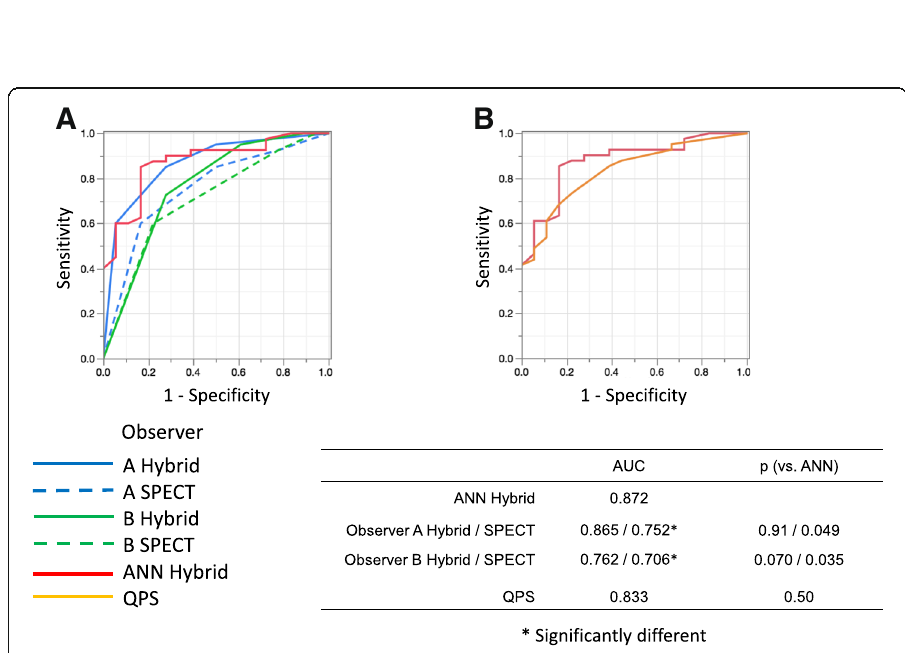
Fig. 2 Areas under ROC curves derived from patient-based analysis by ANN, two observers ( a ), and QPS ( b ). ANN artificial neural network, QPS quantitative perfusion SPECT, ROC receiver operating